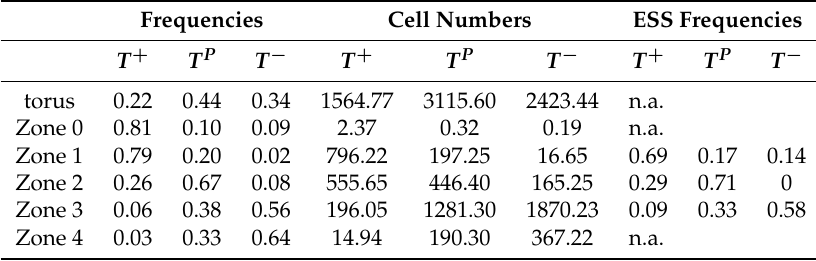
Table 3. Mean frequencies and population sizes of the three cell types averaged over the last 1000 generations. The final three columns provide the non-spatial ESS frequencies for the three zones. Results are from a single run where neighborless cells can proliferate: σ = 0.1. Replicate runs provide very similar outcomes regardless of whether neighborless cells can proliferate or not (Table